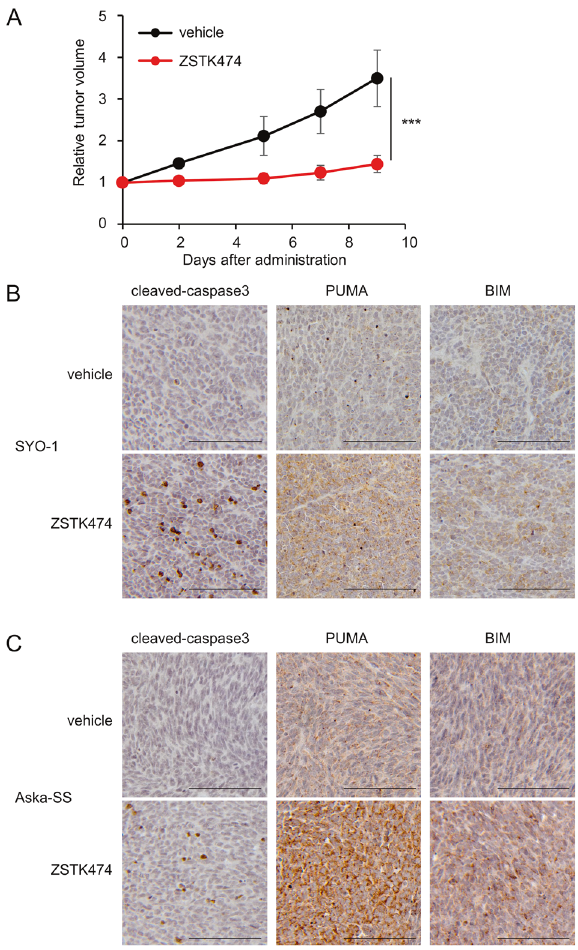
Fig. 5 Administration of a PI3K inhibitor induced apoptosis and the expression of PUMA and BIM resulting in a preferable antitumor effect in a SYO-1 and Aska-SS xenograft model. A In vivo antitumor activity of the PI3K inhibitor ZSTK474 against Aska-SS xenografts. Data are means ± SD. n = 9 for a vehicle group and n = 7 for a ZSTK474 treated group. Statistical analysis was performed by Welch ’ s t -test. *** P < 0.001. B , C The expression levels of cleaved caspase3, PUMA and BIM in SYO-1 ( B ) and Aska-SS ( C ) xenograft tumors from mice treated with or without ZSTK474 at 400 mg/kg once a day for 3 days were analysed by immunohistochemistry. Scale bars, 100 μ